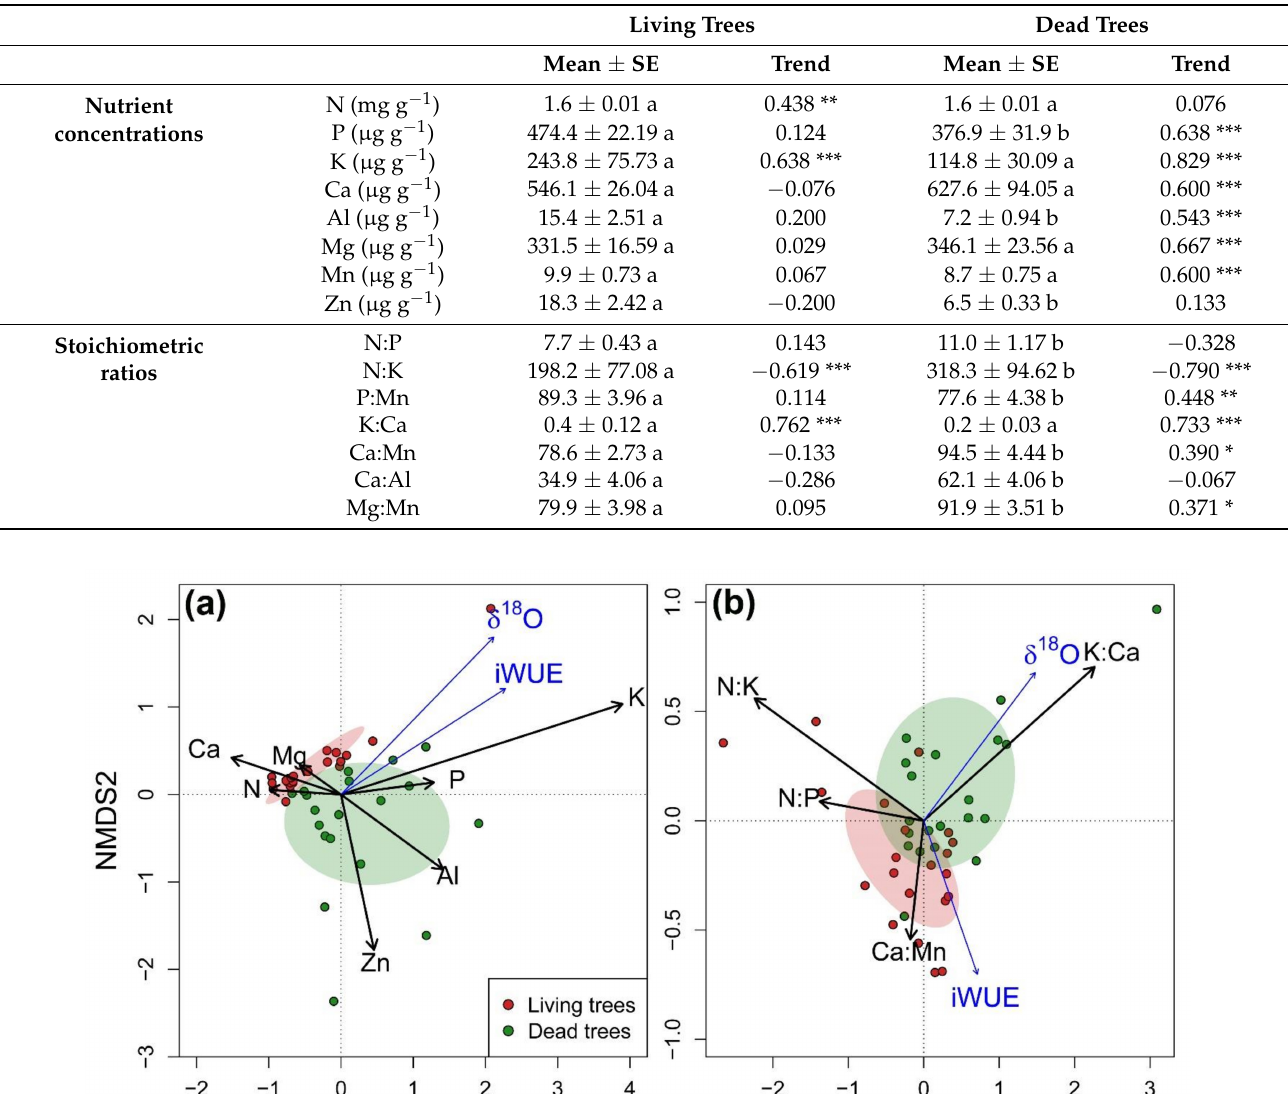
Table 1. Mean ( ± standard errors) of nutrient concentrations and molar stoichiometric ratios. Different letters indicate significant differences ( p < 0.05) between living (L) and dead trees (D) according to Mann–Whitney U tests. Trends are based on the Kendall τ statistic and significance in shown with asterisks (* p < 0.05; ** p < 0.01; *** p < 0.001).